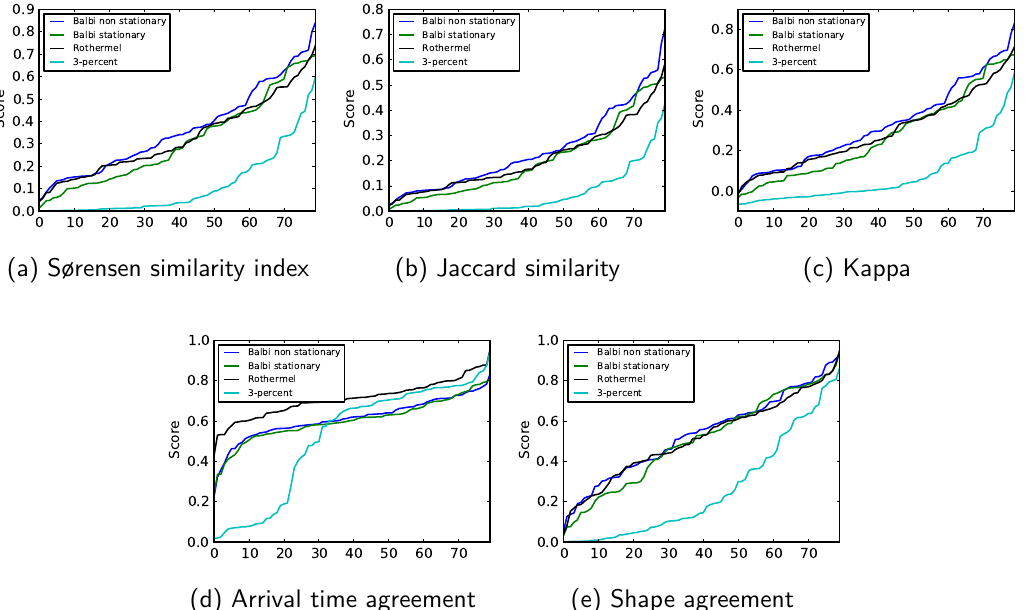
Figure 1. The distribution of the scores for the 80 cases and for the four models. The sorting was carried out independently for each model, hence one cannot compare individuals